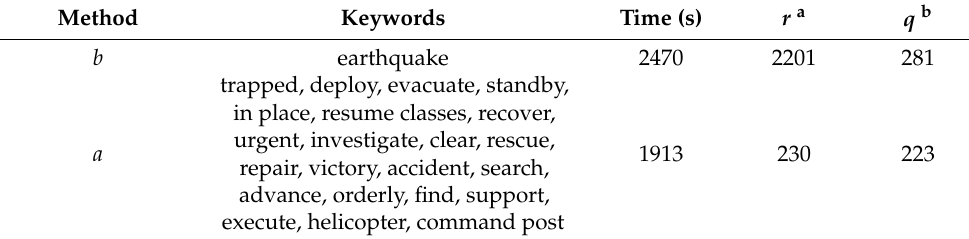
Table 8. Results of the information collection timeliness experiment.